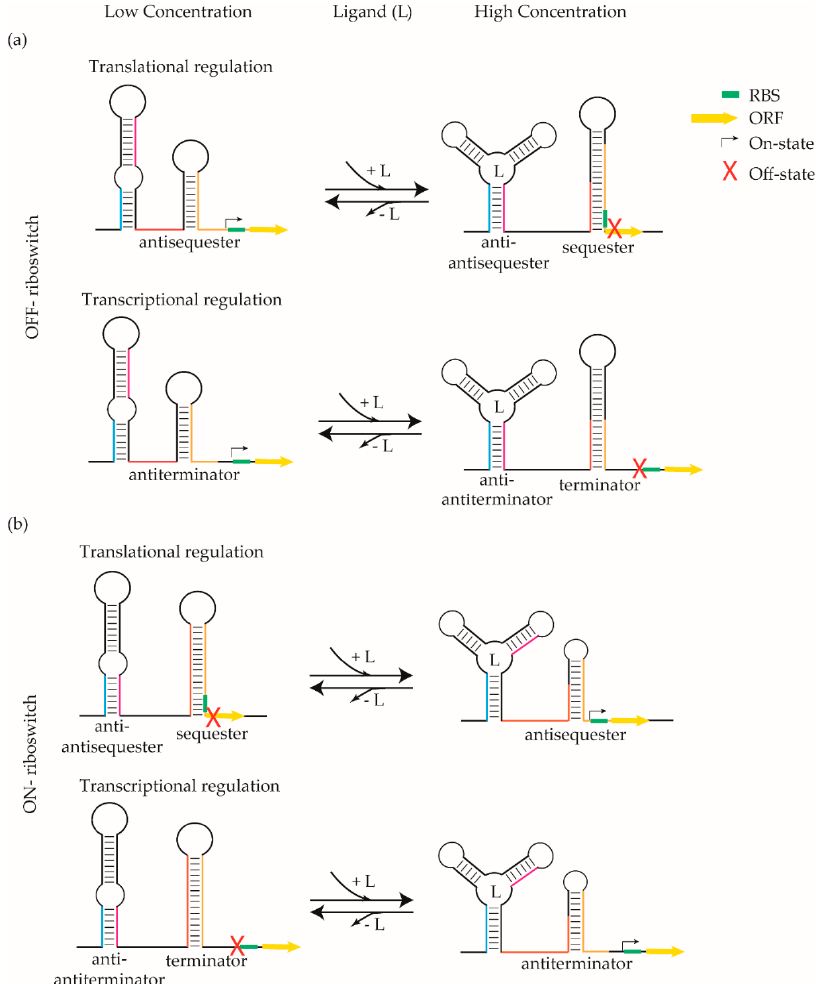
Figure 1. Riboswitch-mediated gene regulation. Bacterial riboswitches regulate the expression of immediate downstream genes by modulating their conformation in response to a change in the concentration of their cognate ligands (L). (Strands involved in the formation of anti-antitermina- tor/anti-antisequester (cyan and magenta) and terminator/sequester (orange and yellow) are color- coded). In most cases, binding of ligand leads to transcriptional and/or translational termination of downstream gene expression (open reading frame (ORF), marked in yellow). These riboswitches are known as “OFF-switches” ( a ). In other cases, ligand binding leads to their expression of down- stream genes and these riboswitches are called “ON-switches” ( b ). In the case of translation regu- lation, the RBS (green box) is either sequestered ( a ) or released ( b ) upon ligand binding. In the case of transcriptional regulation, the RNA polymerase is either stalled by a terminator ( a ) or moves past the antiterminator ( b ) upon ligand binding. RBS: ribosomal binding site.